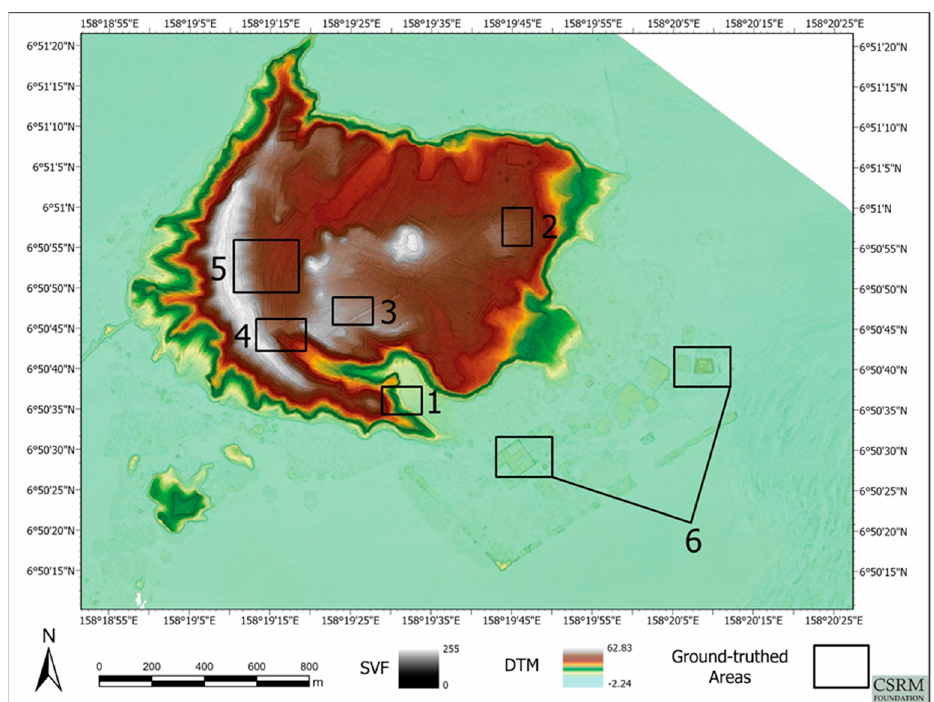
Figure 5. The six areas of interest chosen for field verification of the features revealed by LiDAR and for validation and calibration of the LiDAR